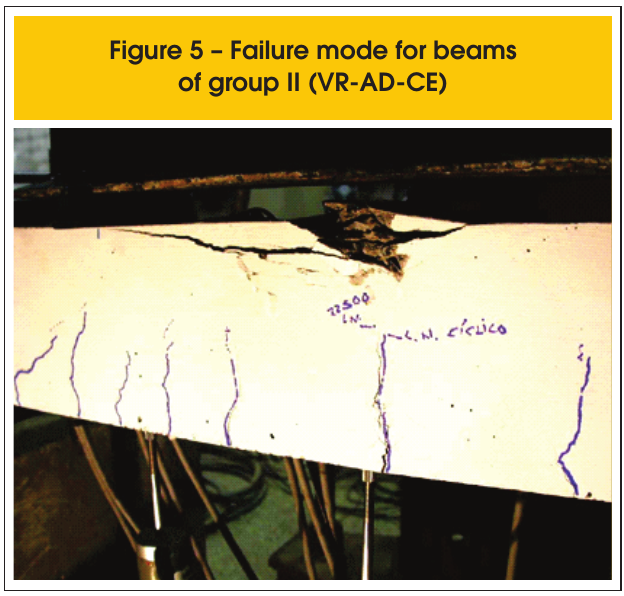
Figure 5 – Failure mode for beams of group II (VR-AD-CE)